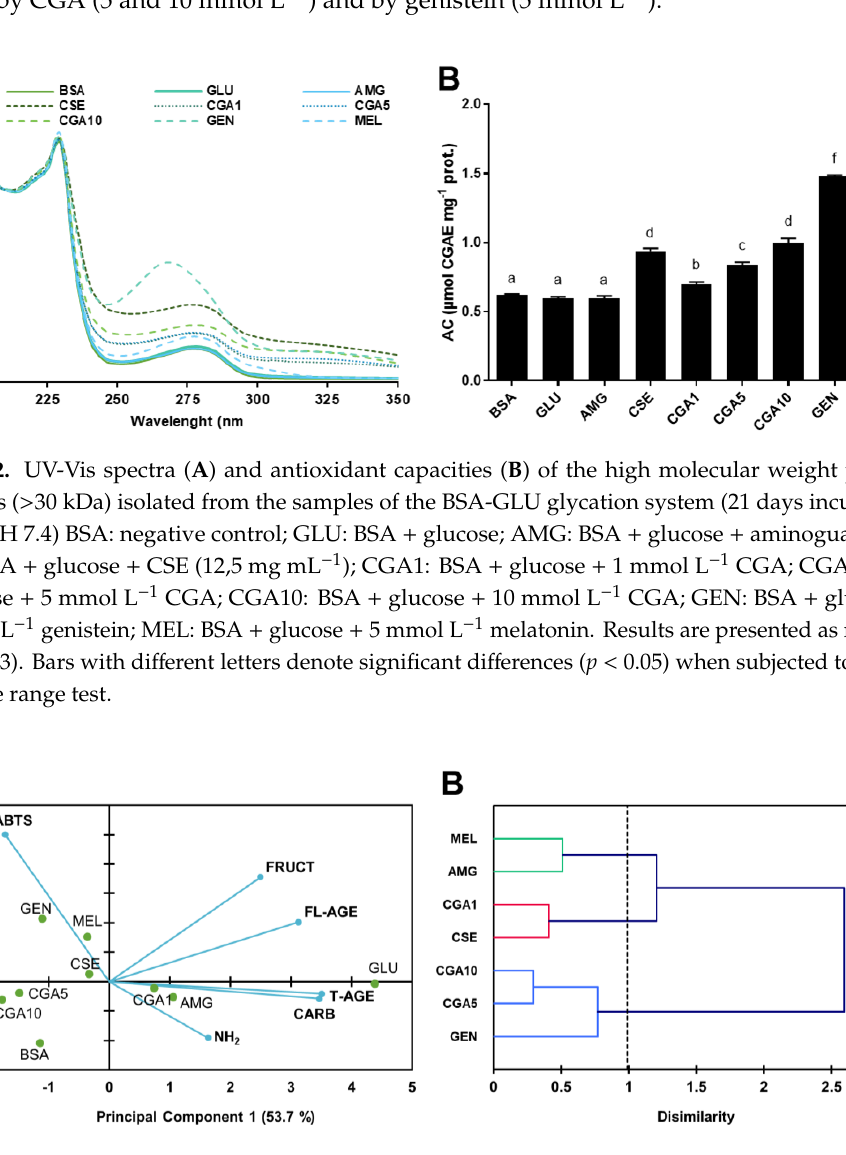
Figure 3. Biplot (scores of samples and load factors of each variable) of the principal component analysis (PCA) ( A ), including the content of free amino groups (NH 2 ), fructosamine (FRUCT), fluorescent AGE (FL-AGE), total AGE (T-AGE), and protein carbonyls (CARB), and dendrogram of hierarchical cluster analysis of the glycation inhibitory activity ( B ) of the samples of the BSA-GLU glycation system (21 days agitation, 37 ◦ C, pH 7.4) BSA: negative control; GLU: BSA + glucose; AMG: BSA + glucose + aminoguanidine; CSE: BSA + glucose + CSE (12,5 mg mL − 1 ); CGA1: BSA + glucose + 1 mmol L − 1 CGA; CGA5: BSA + glucose + 5 mmol L − 1 CGA; CGA10: BSA + glucose + 10 mmol L − 1 CGA;